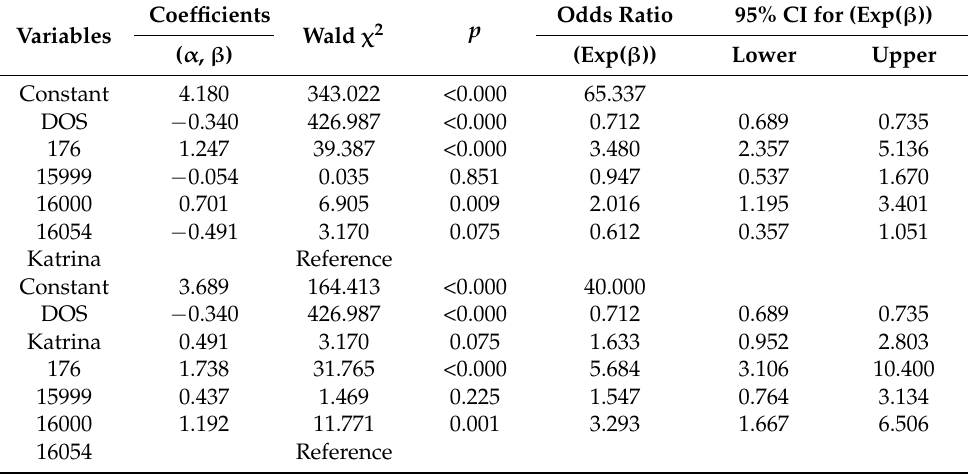
Table 6. Estimation of the multiple logistic regression parameters for the mini-type cultivars and days of storage (DOS) as factors influencing the probability of